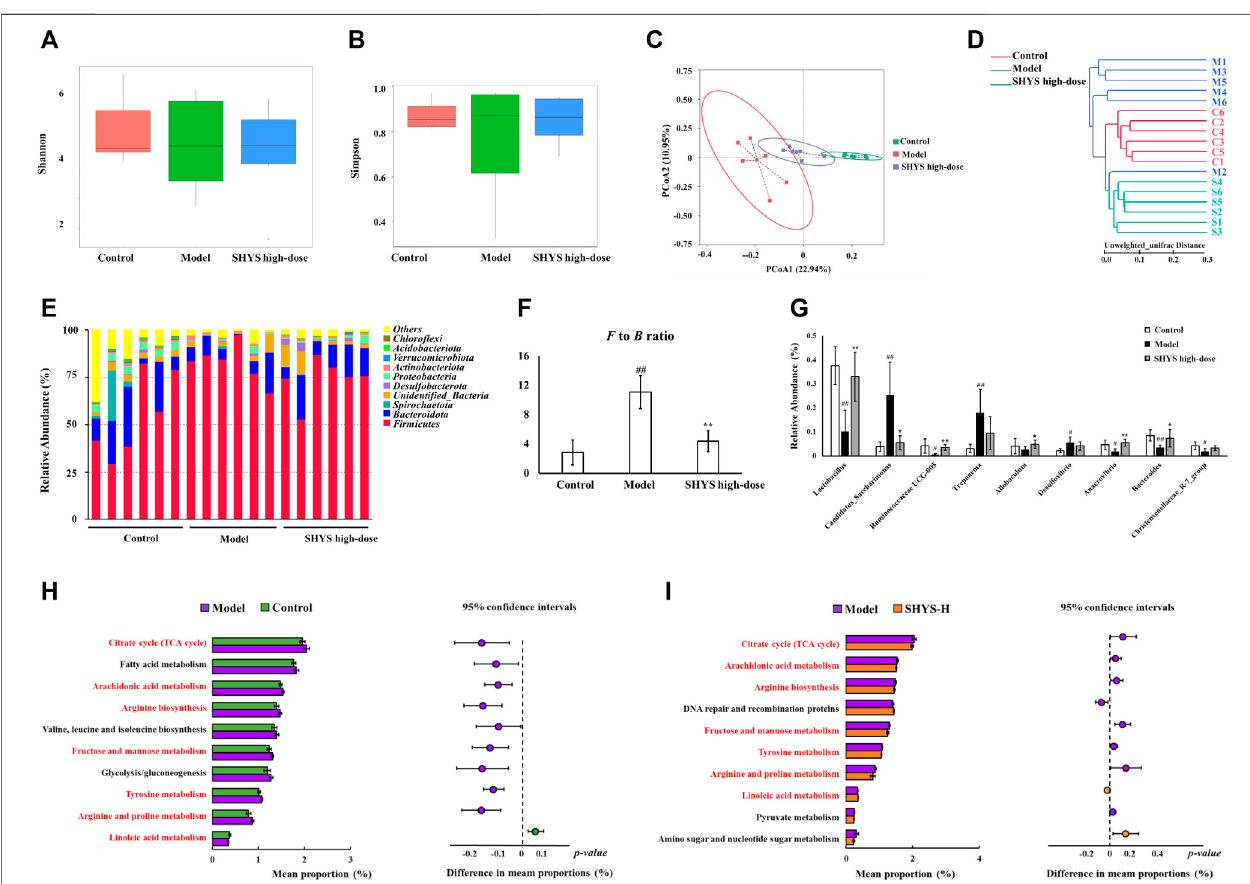
FIGURE3| SHYStreatmentaffectedthediversityandabundancesofgutmicrobiota inDNrats (A,B) Nosigni fi cantdifferenceswereobservedamongtheControl, ModelandSHYShigh-dosegroups. (C,D) PCoAandsystemclusteringtreeindicatedmoresimilarbetadiversitybetweenSHYShigh-doseandControlgroupsthanthat between the Model and Control groups (C: Control group; M: Model group; S: SHYS high-dose group). (E,F) At the phylum level, SHYS treatment decreased the F to B ratioinDNrats. (G) Atthegenuslevel,SHYStreatmentaffectedtherelativeabundancesof Lactobacillus , RuminococcaceaeUCG-005 , Allobaculum , Anaerovibrio , Bacteroides and Candidatus_Saccharimonas inDNrats (H,I) Thedifferentialmetabolicpathways(written inred)ofSHYSonDNwerepredicted using PICRUSt analysis basedonthe16SrRNAsequencingdata.Control,ModelandSHYShigh-dose( n (cid:2) 6pergroup)groups.Dataarepresentedasthemean ± SD. # : p < 0.05ascompared to the Control group; ## : p < 0.01 as compared to the Control group; *: p < 0.05 as compared to the Model group; **: p < 0.01 as compared to the Model group